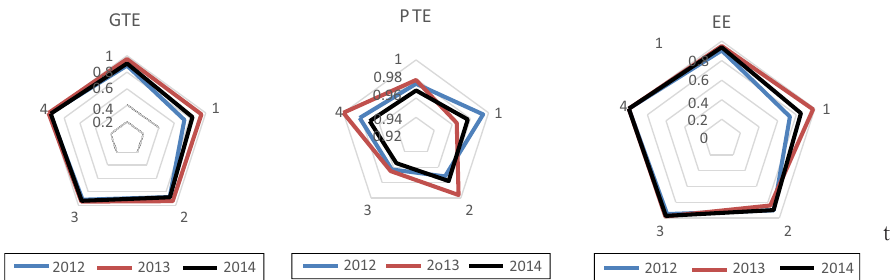
Figure 2. Ef fi ciency index of the seven incubators types (large,